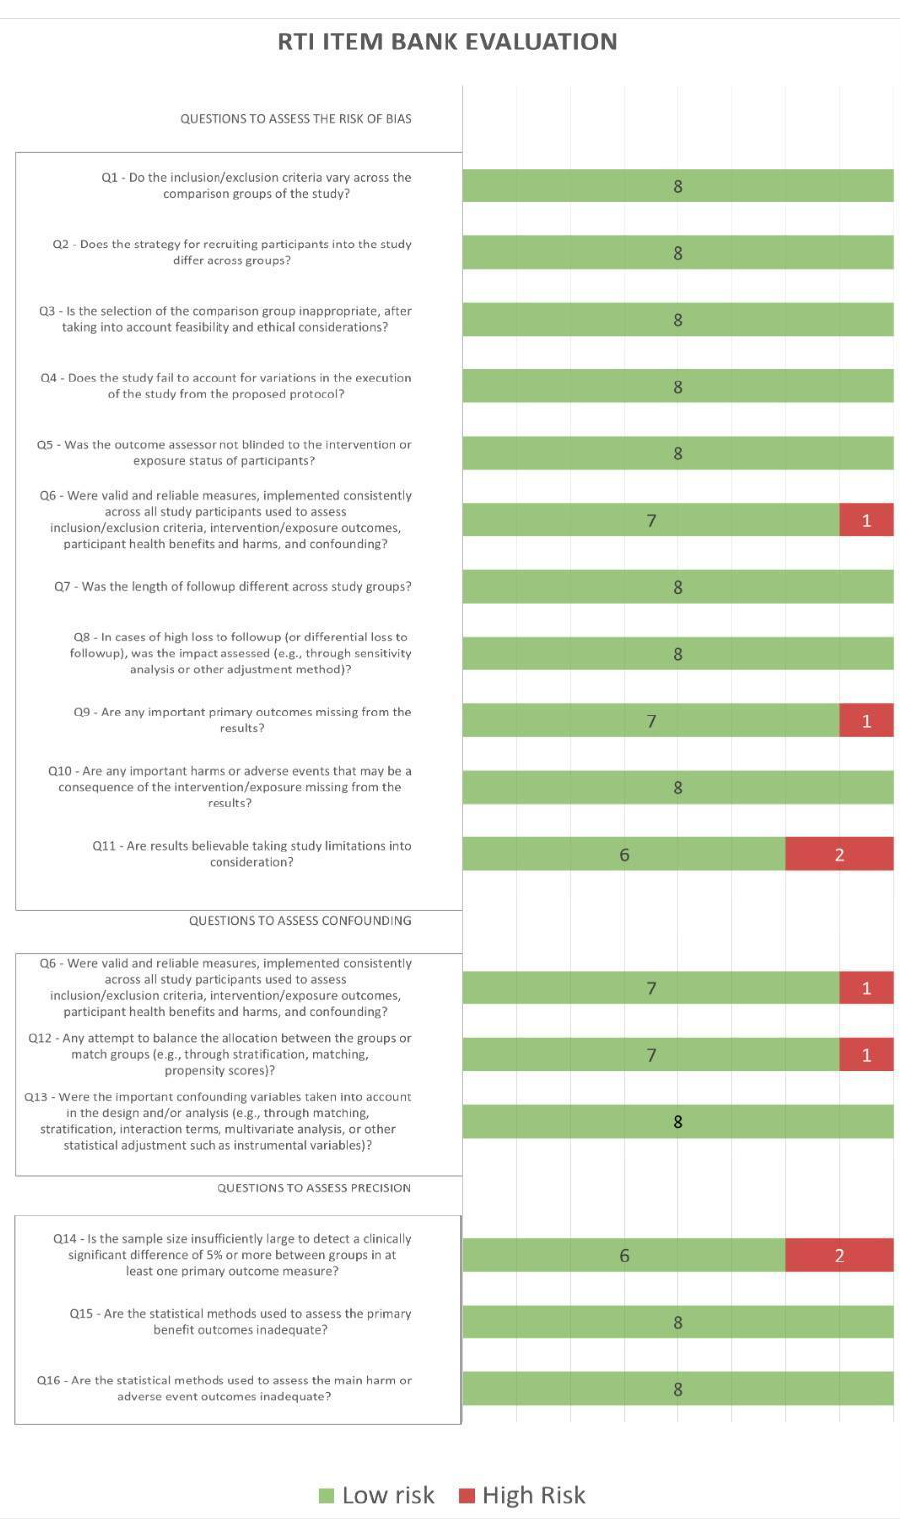
Figure 2. RTI quality and risk of bias in studies included in the meta-analysis.